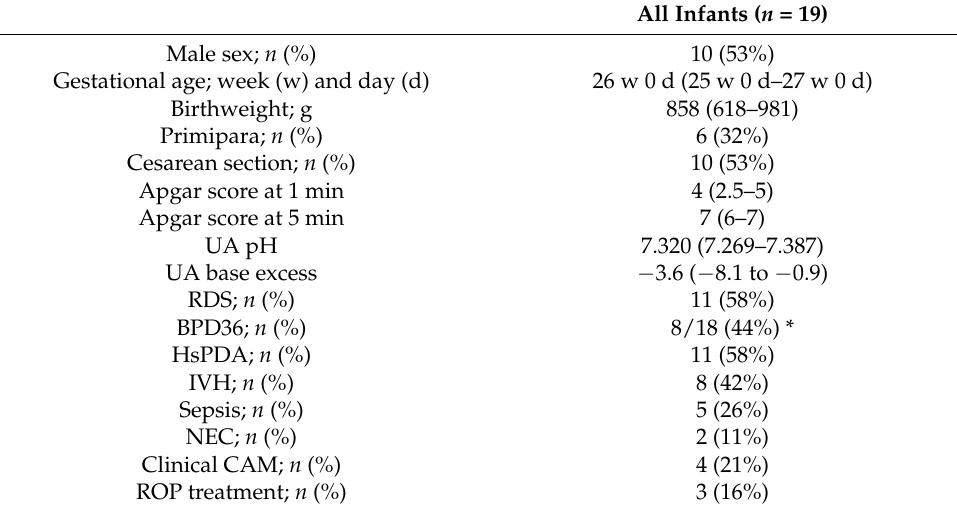
Table 1. Characteristics of included infants.